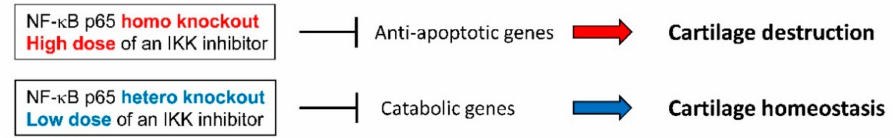
Figure 2. The nuclear factor-kappaB (NF- κ B) level di ff erently regulates cartilage homeostasis and Osteoarthritis (OA). While the complete inactivation of NF- κ B p65 in chondrocytes or a high dose of I κ B kinases (IKK) inhibitor causes OA development by inducing chondrocyte apoptosis, p65 hetero knockout or a low dose of IKK inhibitor alleviates OA by suppressing matrix-degrading